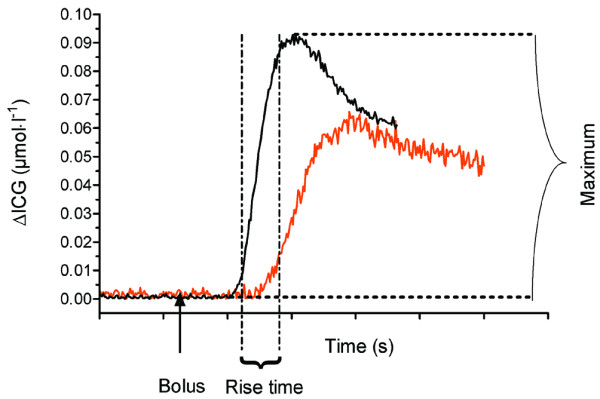
Calculation of the blood flow index. Typical indocyanine green (ICG) measurement in a pig during stable hemodynamics (black line) and at hemodynamic decompensation (orange line).